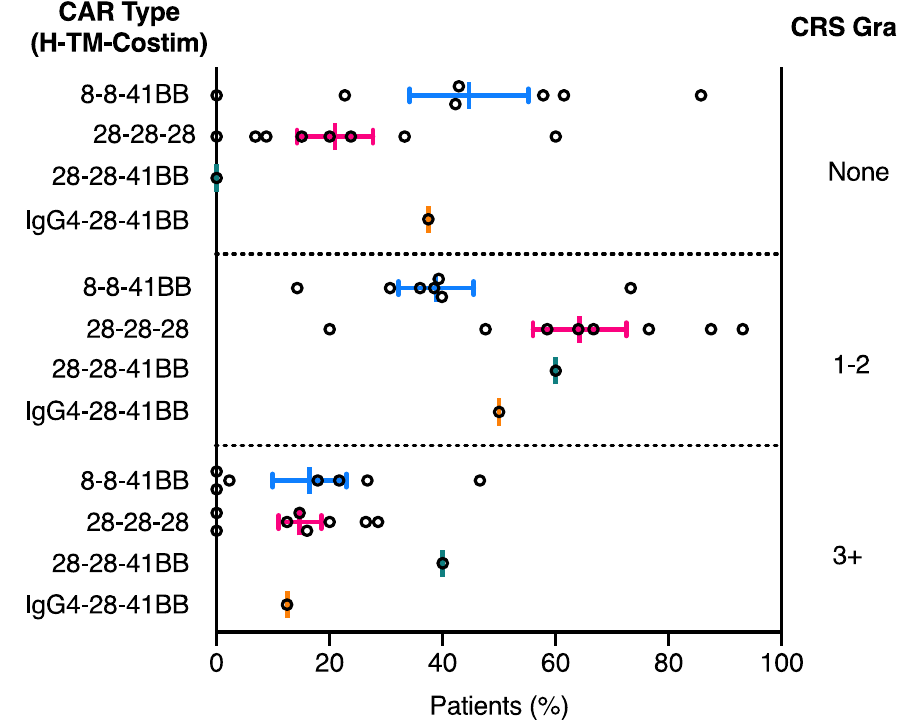
Figure 3. CAR domain structure influences CRS severity in patients treated with CD19 CAR-T cell therapies. Both CAR type, based on hinge (H), transmembrane (TM) and costimulatory (Costim) domain composition, and CRS grade, separated into none, grade 1–2 and grade 3+, are represented on the left and right y axis, respectively. Each circle represents the percentage of patients in a single clinical trial listed in Table 1 that developed the corresponding grade of CRS (none, grade 1–2 and grade 3+). Middle line represents the mean percentage of patients with the corresponding grade of CRS and error bars represent the SEM (Table S2).